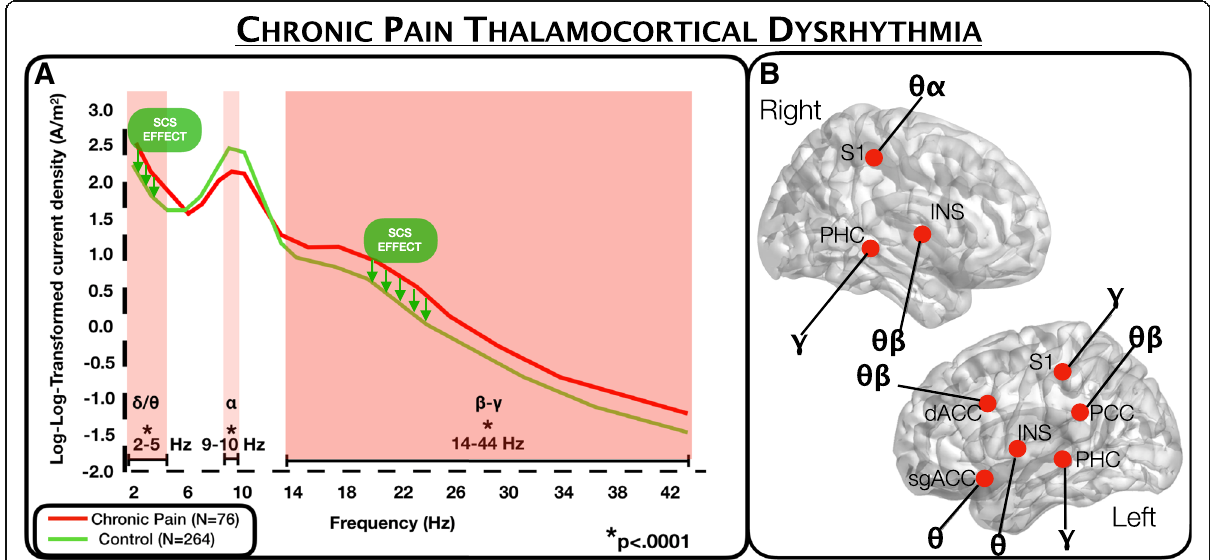
Fig. 9 Chronic pain thalamocortical dysrhythmia is known to occur in distinct band, i.e. most commonly in theta, beta, and gamma bands. Work from De Ridder and Vannesste demonstrate p < .0001) with greatest differences found in theta-beta theta and gamma (Panel a ), source localized to bilateral sensory discriminative pathways SI, which additional affective emotional pathways including dACC, sgACC, bilateral INS, bilateral PHC, and posterior cingulate cortex (Panel b ). Pretrial and or implant characterization of chronic pain patient TCD could inform the practitioner of an optimal SCS paradigm, while post SCS TCD measures could track SCS efficacy (i.e., decrease in predominate θ theta, β beta, γ gamma dysrhythmias) as described by Schulman et al. (2005). dACC dorsal anterior cingulate cortex, sgACC subgenual anterior cingulate cortex, INS insula, PHC parahippocampus, SI primary somatosensory cortex, PCC posterior cingulate cortex, θ theta, α alpha, β beta, γ gamma. Figure adapted from Vanneste et al. (2018) Nature Communications (Vanneste et al.,